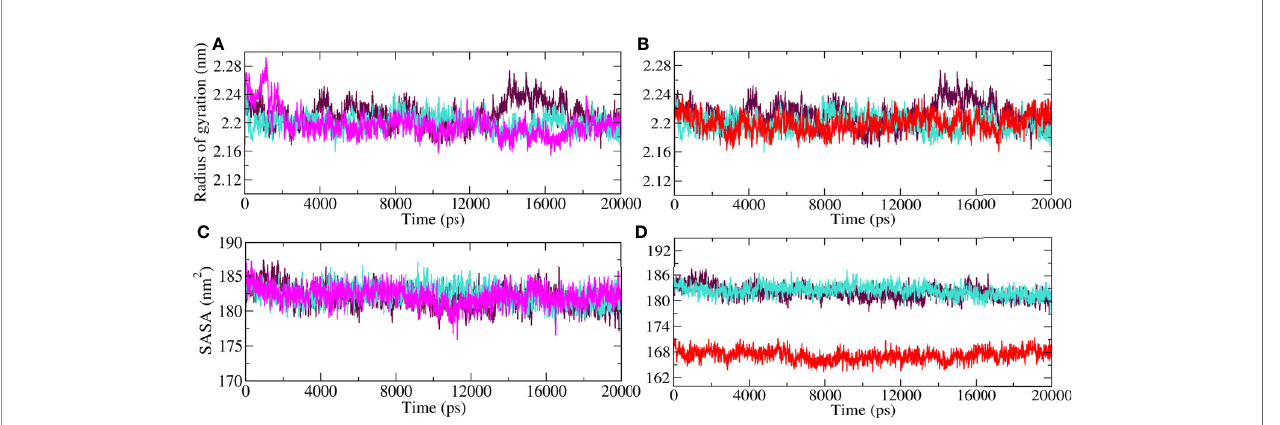
FIGURE 6 | Radius of gyration (Rg) and solvent accessible surface (SASA) region of SARS-CoV-2 main protease in unbound and standard inhibitor ligand/natural lead compound – bound complex. (A) The Rg of the M pro protein and lopinavir/10-Hydroxyaloin A lead – bound complex during 20 ns MD simulation. (B) The Rg of the solvated M pro protein and lopinavir/Isoquercetin lead – bound complex during 20 ns MD simulation. (C) The SASA values of M pro protein and lopinavir/10-Hydroxyaloin A lead – bound complex during 20 ns MD simulation. (D) The SASA values of M pro protein and lopinavir/Isoquercetin lead – bound complex during 20 ns MD simulation. Unbound protein, black color; Aloe vera – bound complex, pink; Neem-bound complex, red; and Lopinavir-bound complex is shown in light-blue